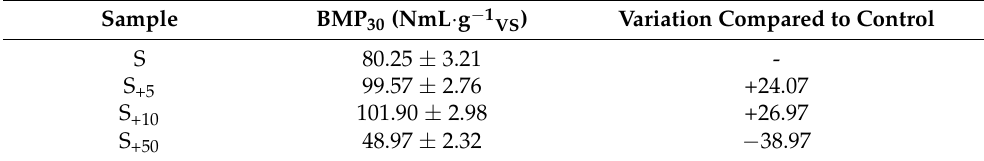
Table 3. BMP 30 of